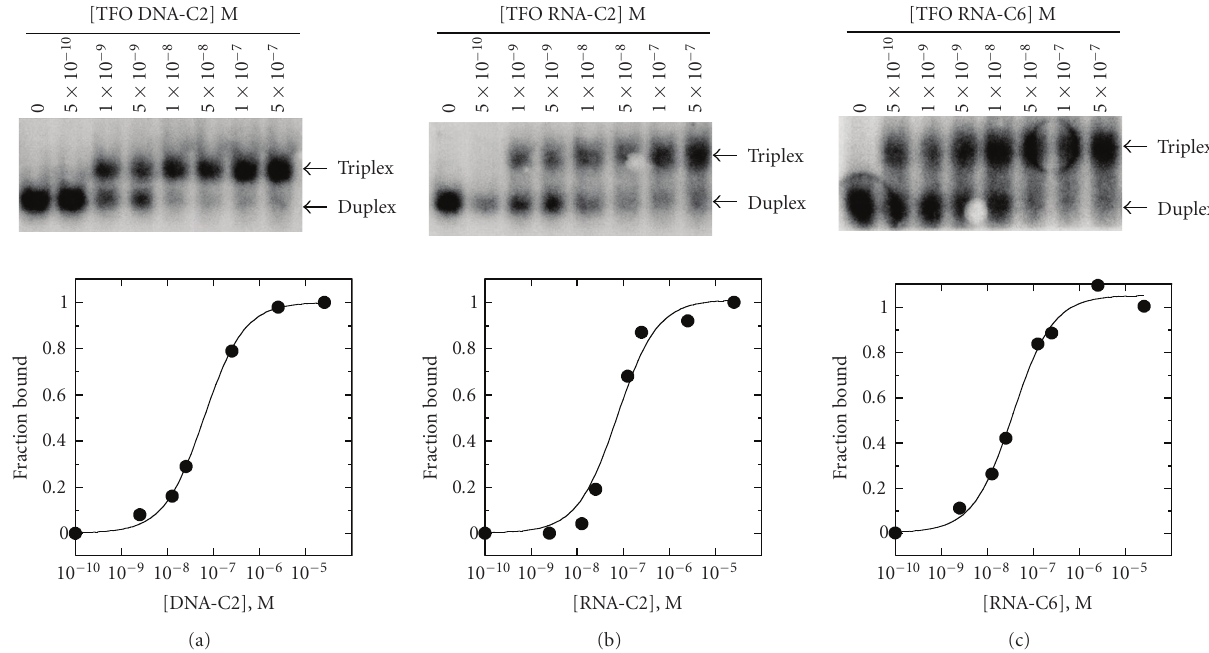
Figure 2: Noncovalent binding of TFOs to duplex target. Varying concentrations of (a) TFO DNA-C2, (b) TFO RNA-C2, and (c) TFO RNA- C6 were incubated with 5 nM target DNA duplex overnight before polyacrylamide gel electrophoresis under nondenaturing conditions. Gel bands were quantified and the data was fit with a two-state binding model.